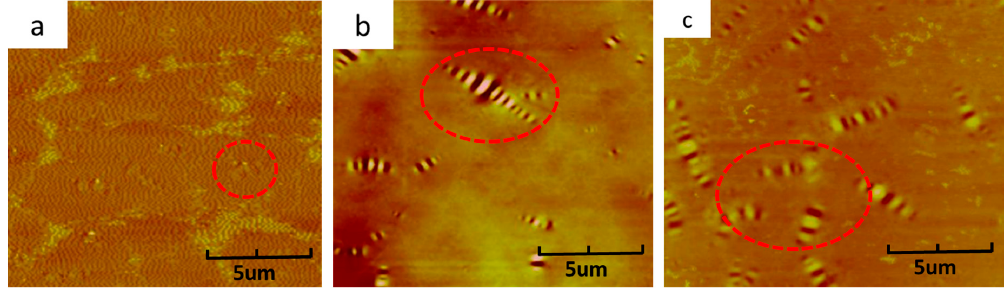
Figure 4. AFM images of virgin bitumen, TFOT aged bitumen and PAV aged bitumen: ( a ) virgin bitumen, ( b ) TFOT aged bitumen, ( c ) PAV aged bitumen. bitumen, ( b ) TFOT aged bitumen, ( c ) PAV aged bitumen.